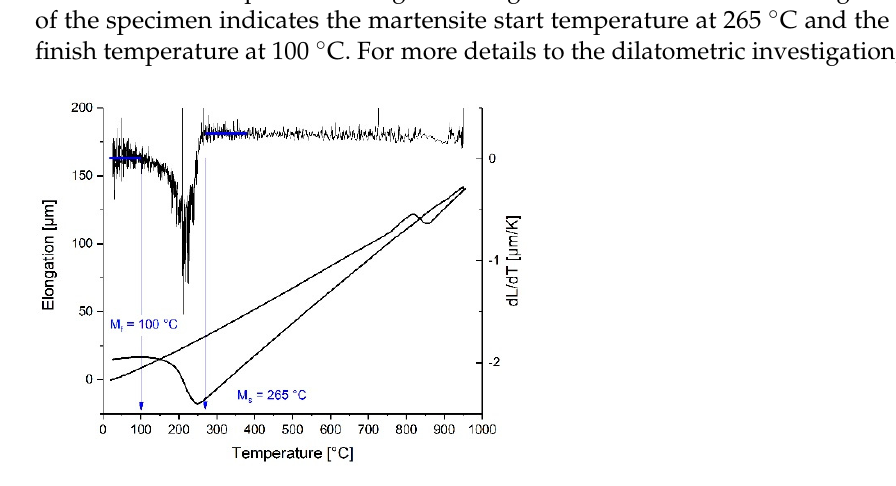
Table 1. Chemical composition (wt.-%) of the investigated material.